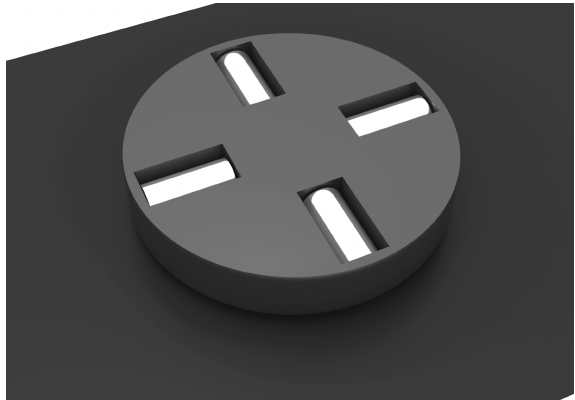
Figure 5. Principle of permanent magnet insertion by pausing printing process at last layer of magnet cavities and before printing closing layer, with magnets alternating in magnetization